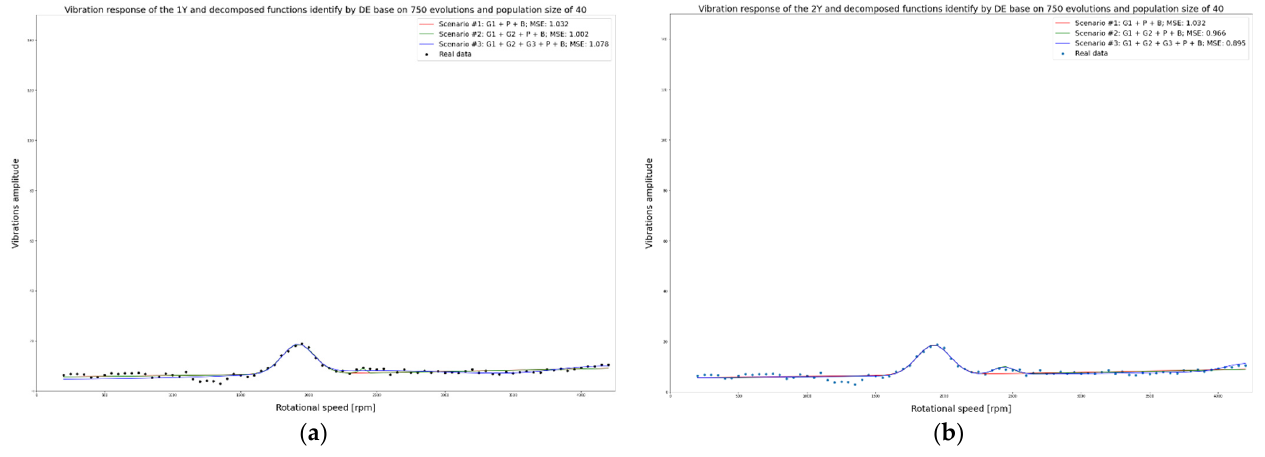
Figure 9. MD3 method outcome based on three scenarios proposed in Section 2 on a test rig without malfunction: ( a ) Data obtained from the 1Y sensor, driver side of the rotor; ( b ) Data obtained from the 2Y sensor, non-driven side of the rotor. Table 5. The MSE values, based on the scenario and sensor location, for the reference transient simulation on the test rig.